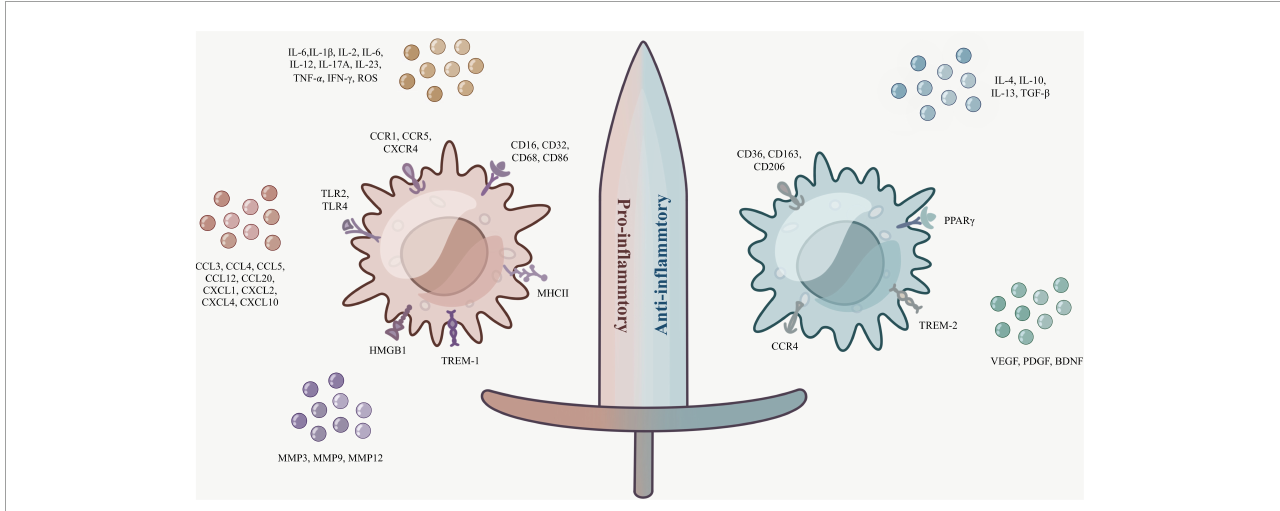
FIGURE1 Microglia/macrophages are a double-edged sword. The surface markers and secretory factors of M1 (pro-inflammatory type) and M2 (anti-inflammatory